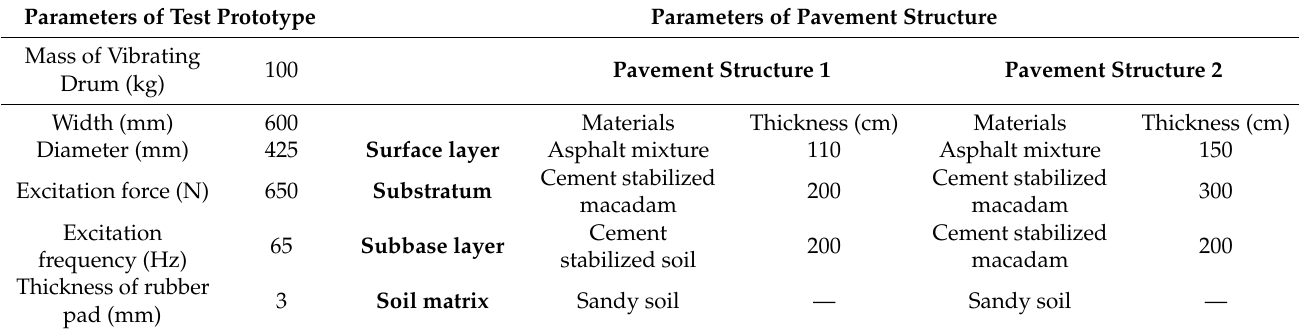
Table 4. Parameters of test prototype and test pavement structure.